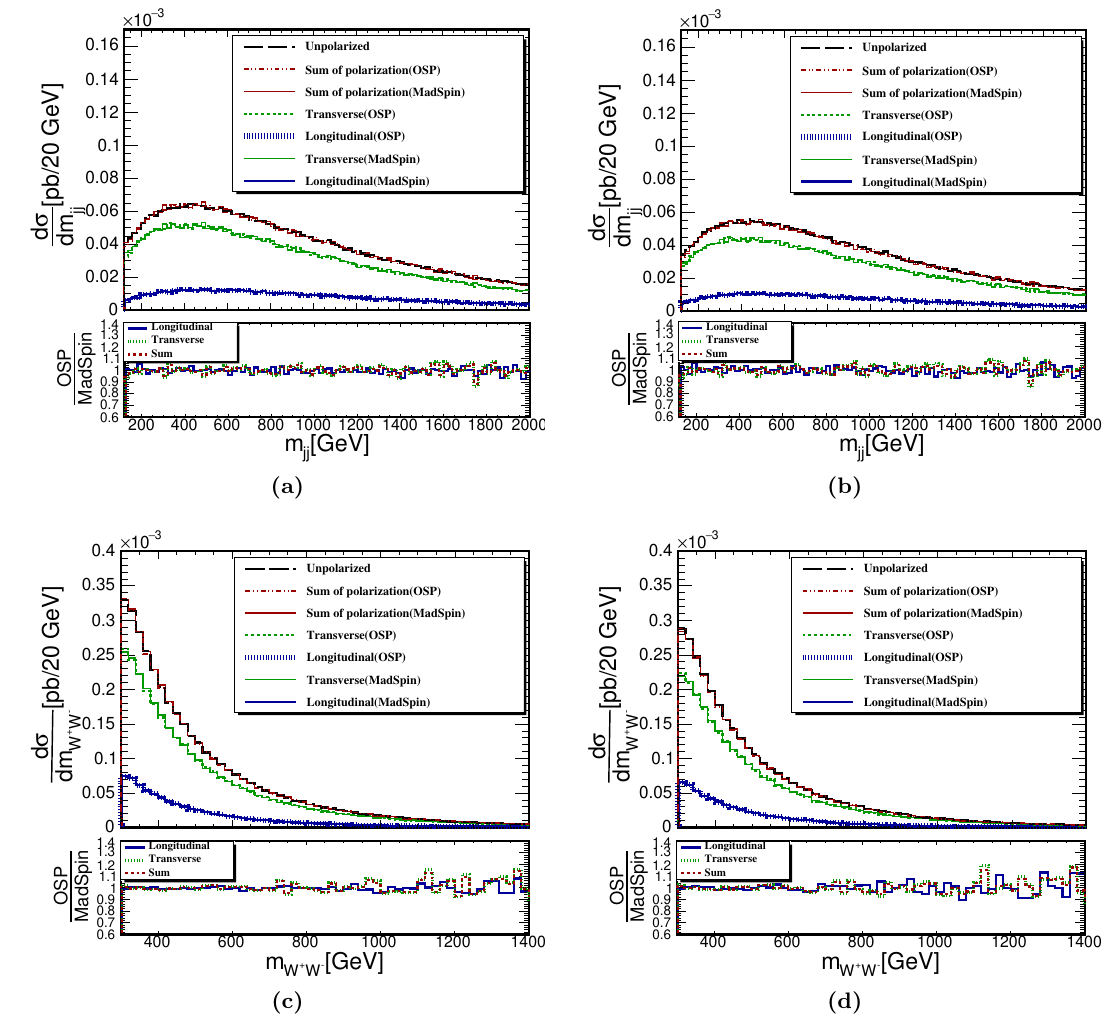
Figure 5. Same as (cid:12)gure 4 but for (a,b) M ( jj ) and (c,d) M ( W + W (cid:0)